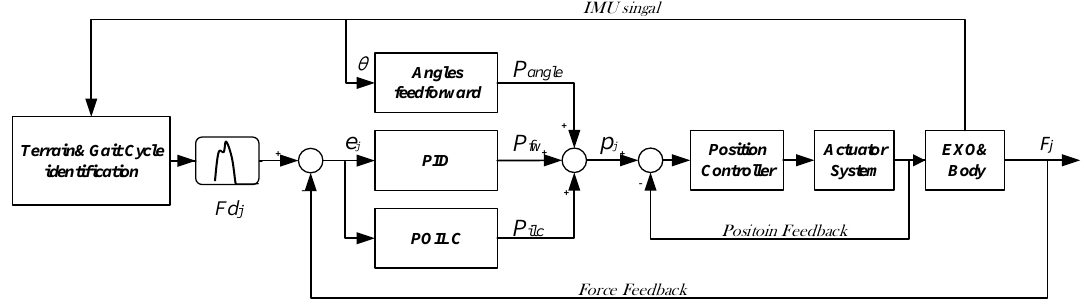
Figure 7. Control architecture with parameter optimal iterative learning control (POILC) and angles feedforward scheme in parallel with PIDfeedback